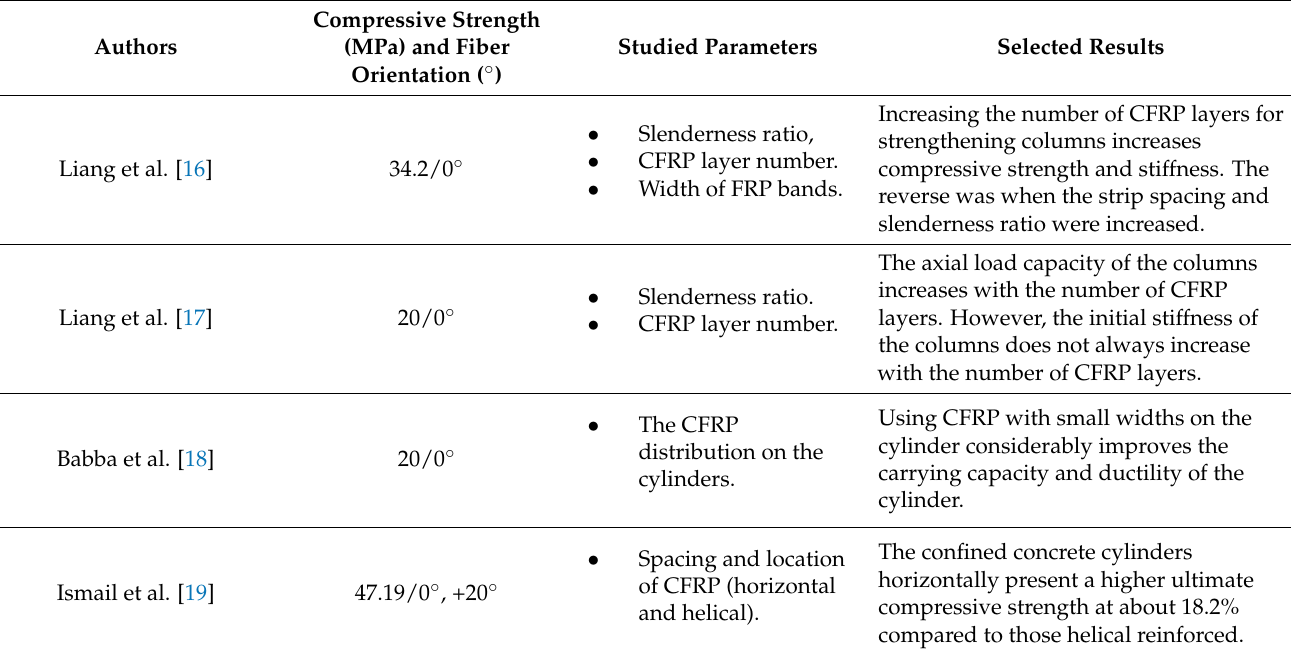
Table 1. A review of previous studies on concrete reinforcement using CFRP